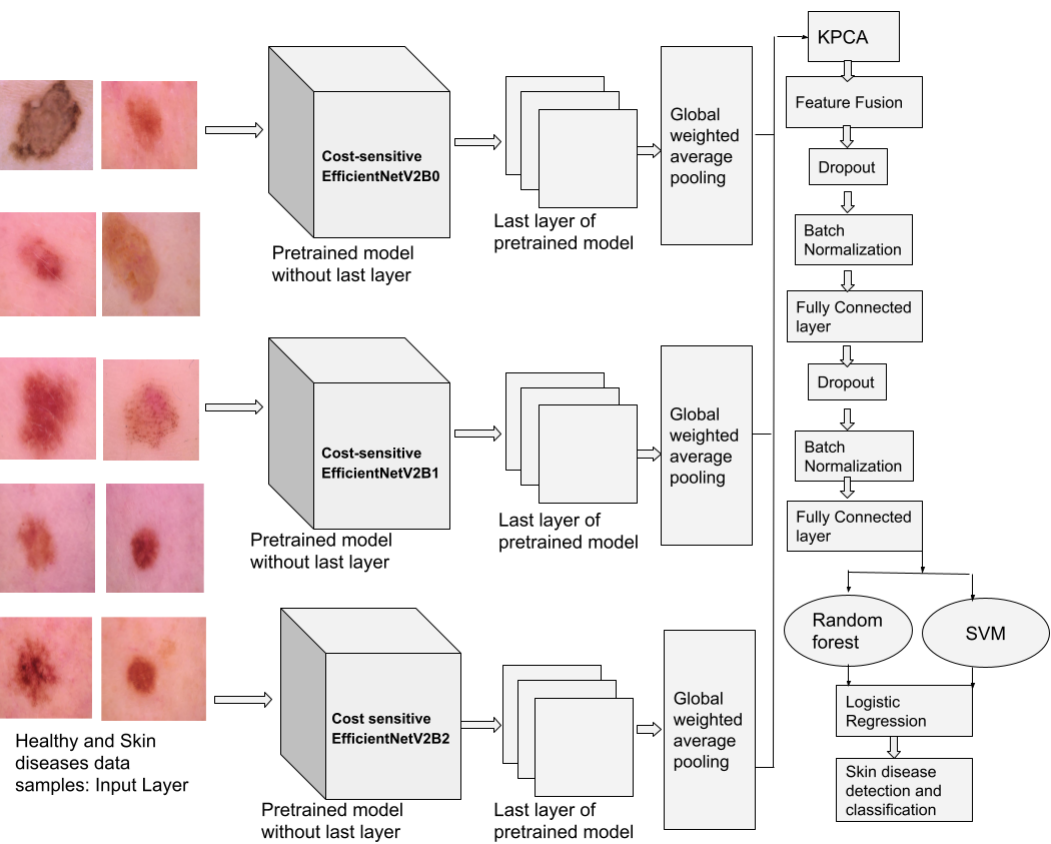
Figure 1. Proposed methodology for skin disease detection and skin disease